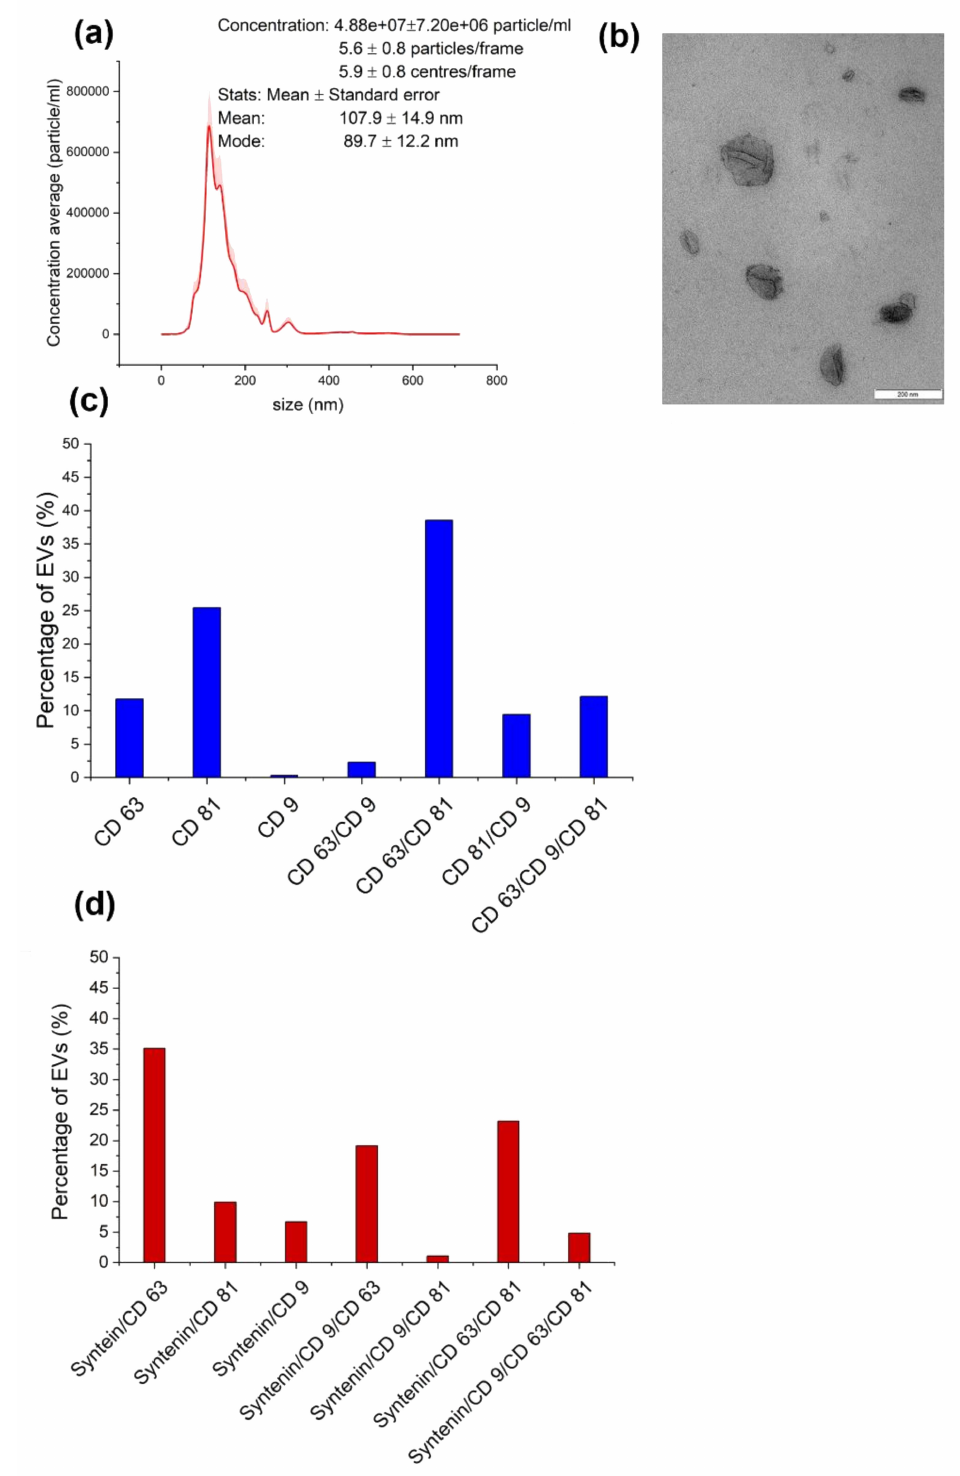
Figure 2. EV characterization ( a ) Nanoparticle tracking analysis (NTA) (Nanosight NS300) result from three different EV preparations at camera level 14 and detection level 3. ( b ) TEM negative staining of EV preparation. ( c ) Tetraspanin distribution measured by Exoview, expressed in the percentage of single, double, or triple positive tetraspanin EVs versus the total captured EVs. ( d ) Exoview, cargo analysis, and co-localization of syntenin 1 with a single tetraspanin and a combination of tetraspanins on single EVs, shown as a percentage of syntenin-1-positive